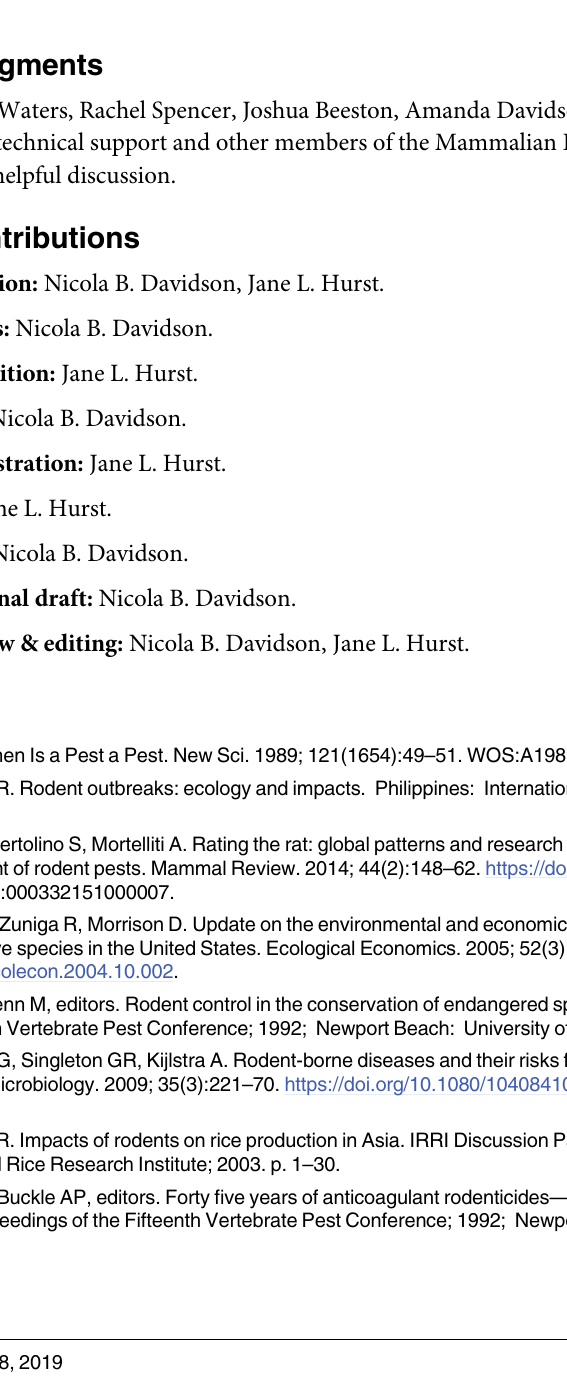
S7 Fig. Sound of rat movement playback recording. (TIF) S8 Fig. Regularly intermittent white noise playback. (TIF) S1 Table. Numbers and types of 50 kHz rat calls for each donor rat. (XLSX) S1 Dataset. Full behavioural test results for each experiment.